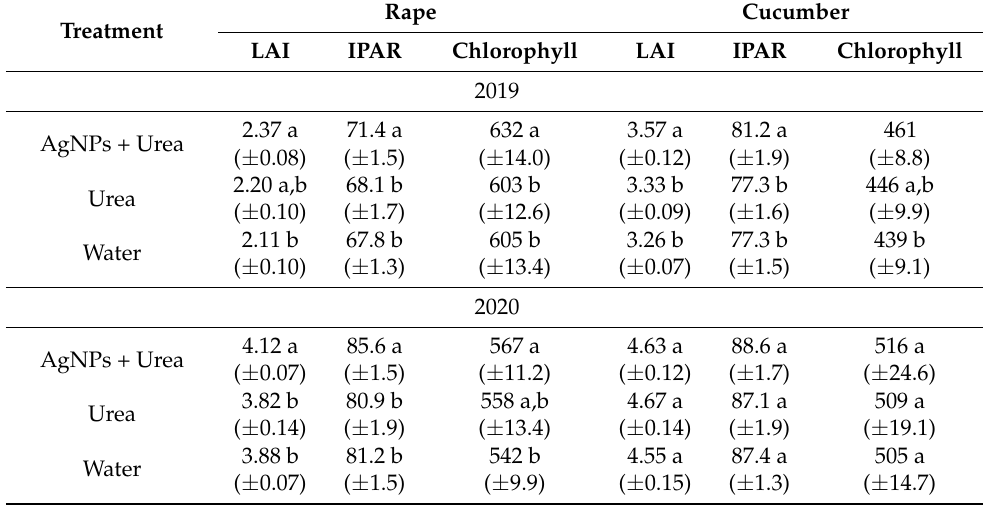
Table 5. The value of the LAI and IPAR indices and the content of chlorophyll depending on the foliar application of AgNPs treatments; urea solution with AgNPs (AgNPs + Urea), urea solution (Urea), water (Water). a, b—letters in the columns for LAI, IPAR, and Chlorophyll indicate a significant difference of their values at p < 0.05. Rape Cucumber Treatment LAI IPAR Chlorophyll LAI IPAR Chlorophyll